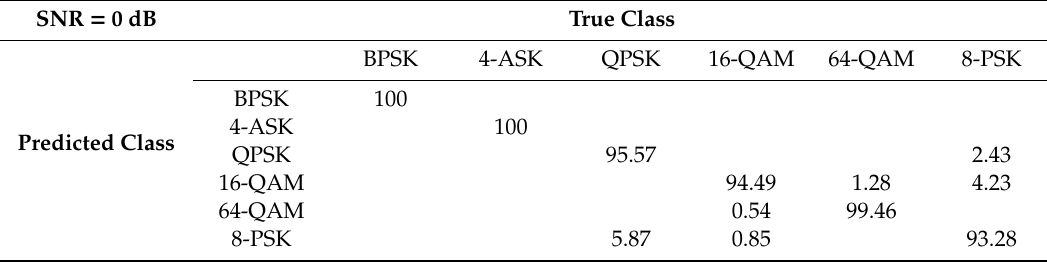
Table 3. Confusion Matrix of NSVM at SNR = 0